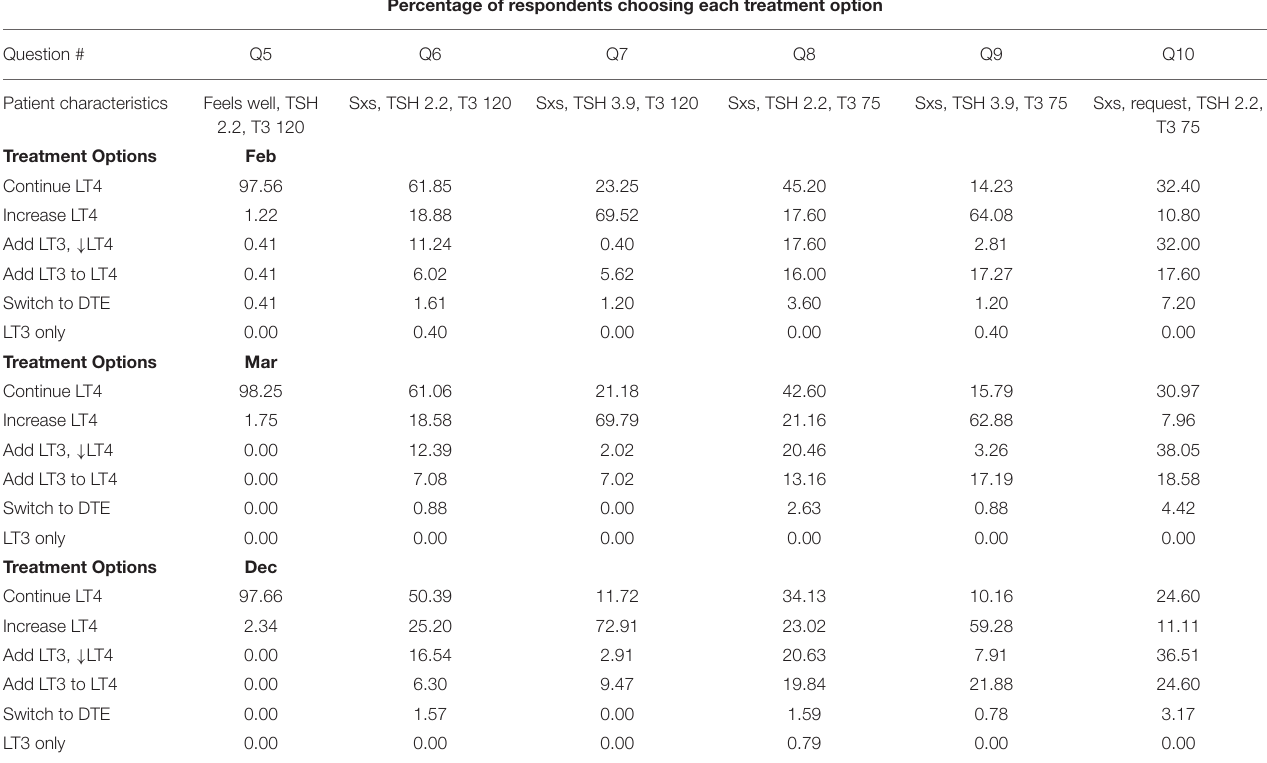
TABLE 2A | Response to questions regarding therapy